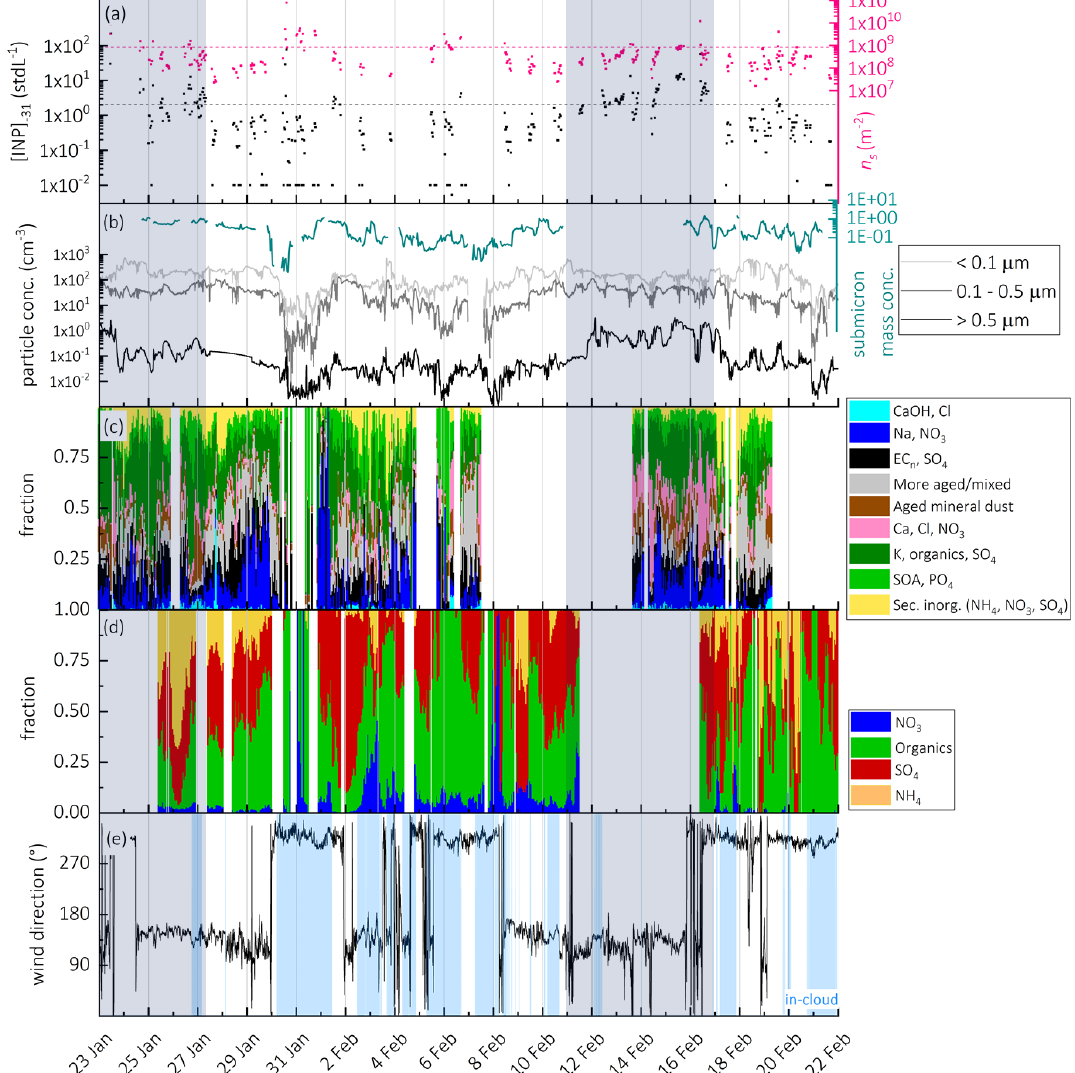
Figure 2. Time series of (a) [INP] − 31 (incl. INP < LOD) (black) and n s (based on INP > LOD) (pink) at − 31 ◦ C, determined with HINC (dashed lines indicate median [INP] − 31 and n s values from Lacher et al. (2018a); (b) particle number concentration for different size bins from the SMPS ( < 0 . 5µm) and OPC ( > 0 . 5µm), and submicron mass concentration derived from AMS measurements; (c) relative abundance of particle types (based on particle number) during the campaign as measured with the LAAPTOF; (d) fractional contribution of the non-refractory aerosol compounds derived from the AMS measurements; (e) wind direction and in-cloud conditions.